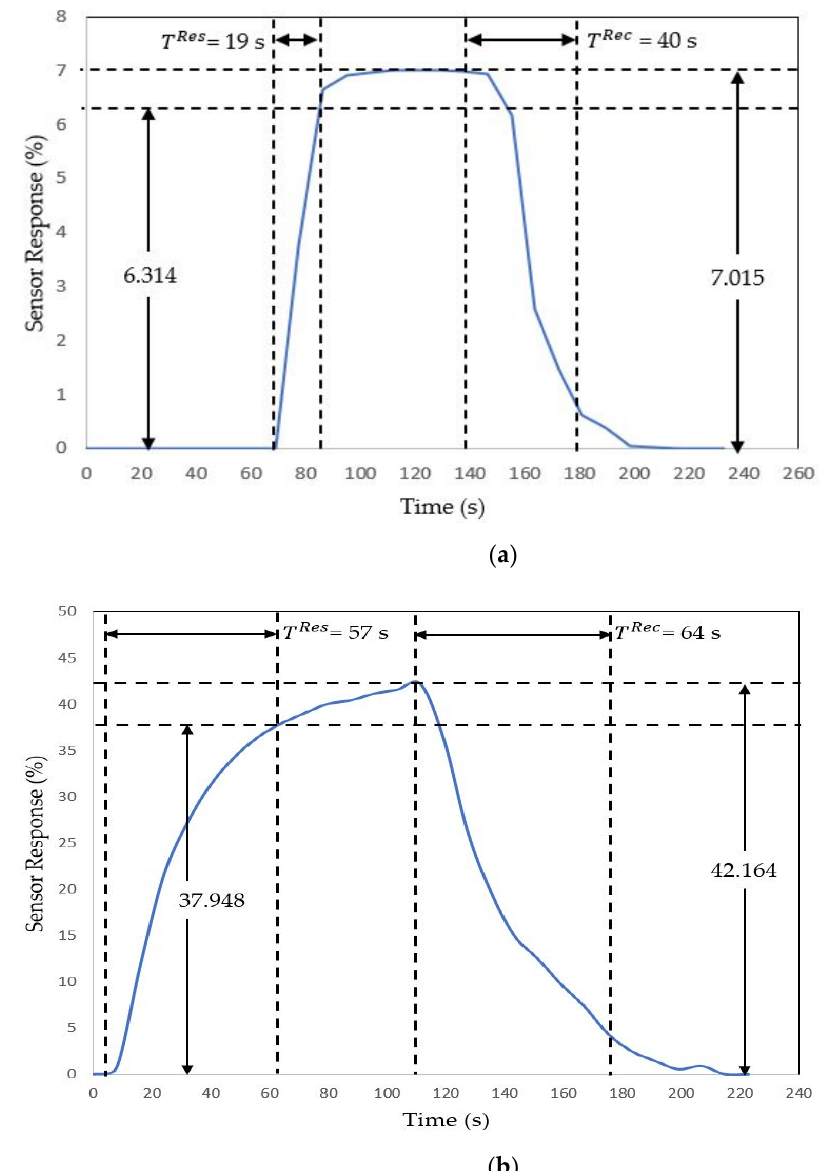
Figure 8. Gas sensor response and recovery time measurement ( a ) RGO ( b ) MOX.